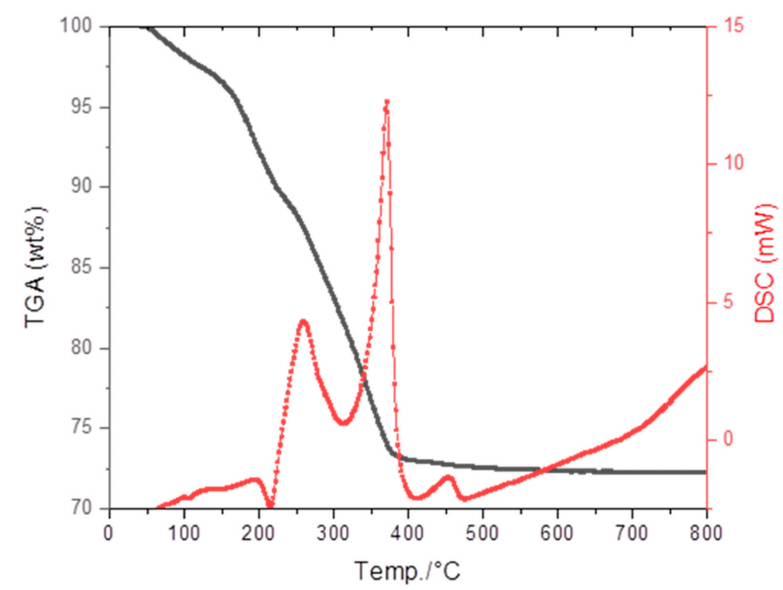
Figure 2. Di ff erential scanning calorimetry / thermal gravimetric analysis (TGA / DSC) of Na- β ”-Al 2 O 3 tape. The black curve and left axis display thermal gravimetric weight loss, while the red curve and right axis display the DSC data (exotherm up).